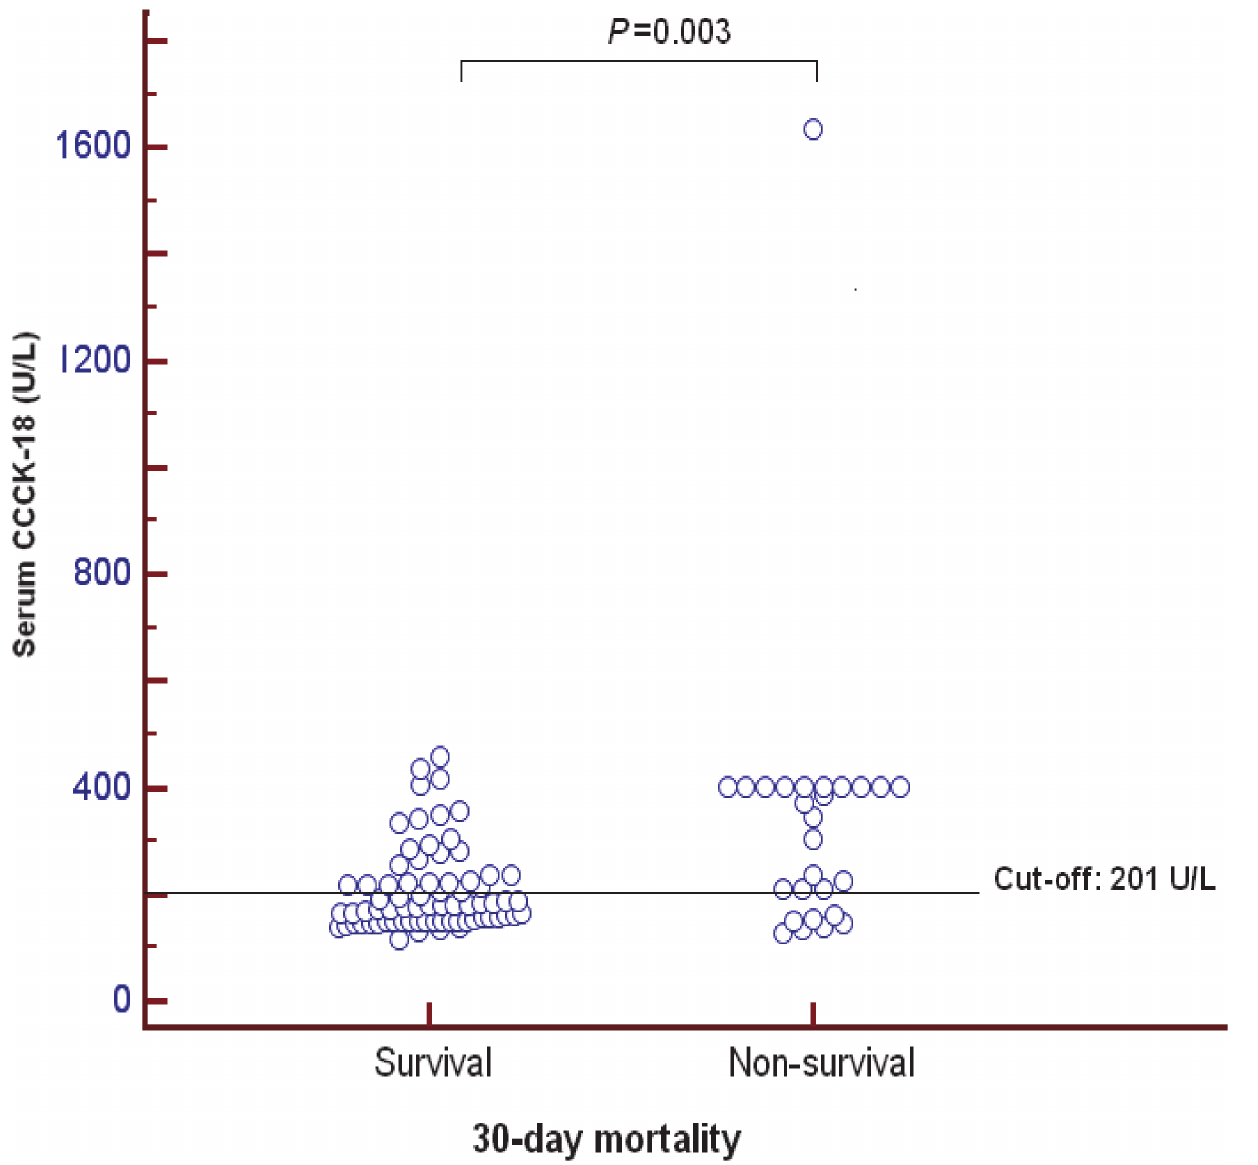
Fig 3. Dot-plot of serum caspase-cleaved cytokeratin (CCCK)-18 levels in 30-day surviving and non-surviving